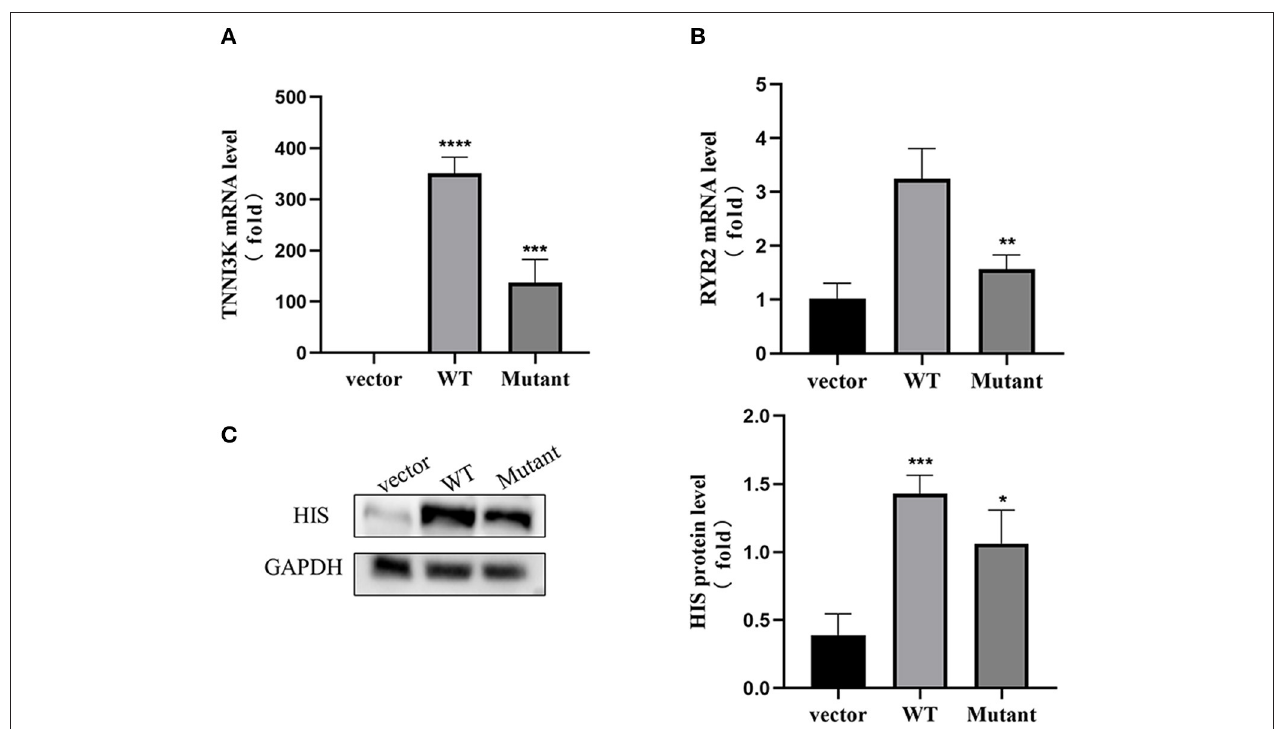
FIGURE 4 | Pathogenicity evaluation of the missense variant of TNNI3K gene in AC16 cell model. (A) The mRNA level of TNNI3K in WT group was significantly increased compared to vector group, while the mRNA level was significantly decreased in mutant group compared with WT group ( n = 4, **** p < 0.0001 vs. vector group, *** p < 0.001 vs. WT group). (B) The mRNA level of RYR2 in mutant group was significantly decreased compared to WT group ( n = 4, ** p < 0.01 vs. WT group). (C) Western blots: DSG2 protein was increased in WT group compared with vector group, while the protein level was decreased in mutant group compared with WT group ( n = 4, *** p < 0.001 vs. vector group, * p < 0.05 vs. WT